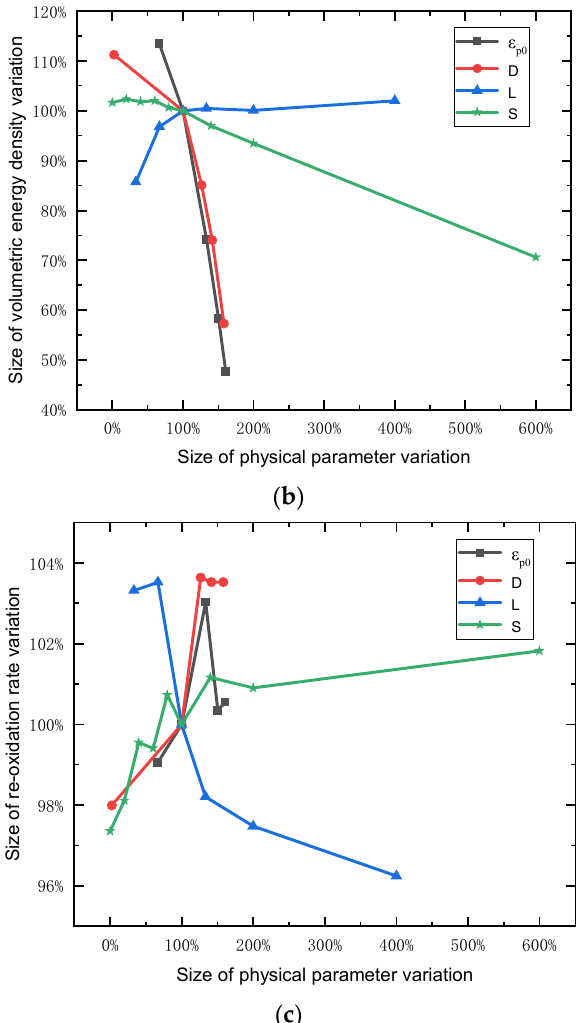
Figure 7. Sensitivity analysis of cobalt-oxide honeycomb structures. ( a ) Sensitivity analysis of conversion rate; ( b ) Sensitivity analysis of volumetric energy density; ( c ) Sensitivity analysis of re-oxidation rate.